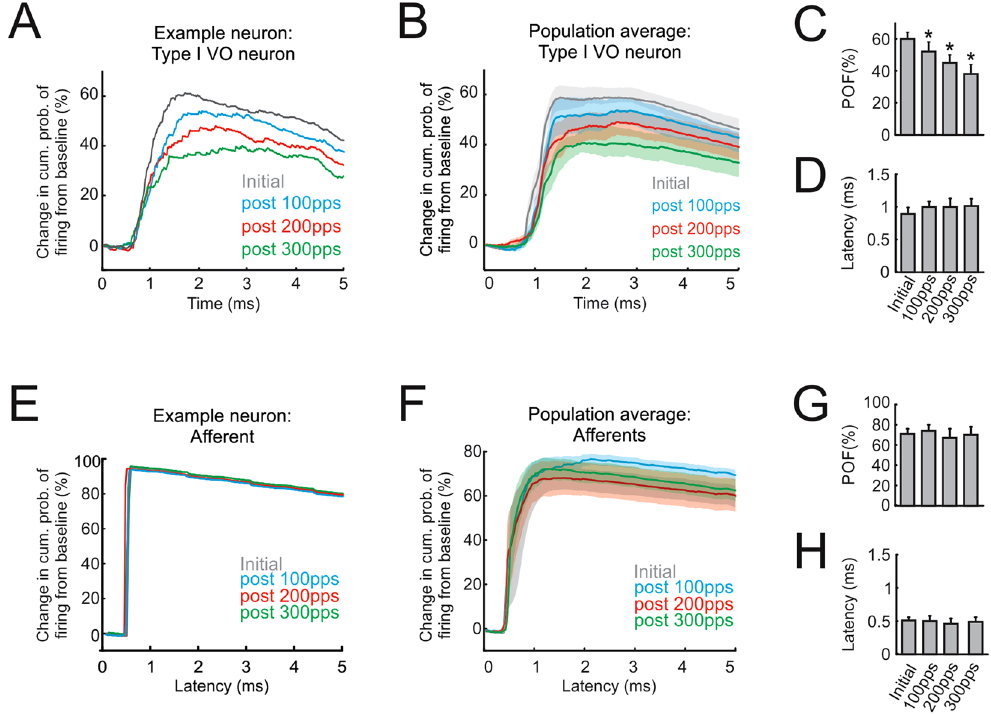
Figure 3. Modulation of vestibular afferent firing remains robust following activation. ( A,B ) Change in cumulative probability of firing from baseline for example ( A ) and population ( B ) of type I VO neurons before and after activation of the vestibular nerve. ( C,D ) Probability of firing ( C ) and latency ( D ) calculated from the change in probability of firing from baseline curves for type I VO neurons. ( E,F ) Change in cumulative probability of firing from baseline for example ( E ) and population ( F ) of vestibular afferents before and after activation of the vestibular nerve. ( G,H ), Probability of firing ( G ) and latency ( H ) calculated from the change in probability of firing from baseline curves for vestibular afferents. Shaded area represent ±